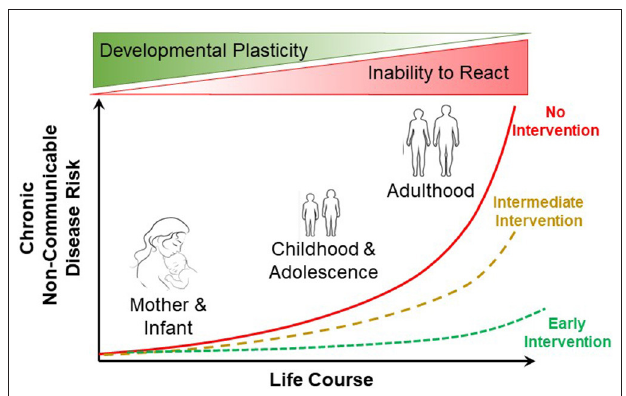
FIGURE 1 | Influence of early life course intervention on the risk of non-communicable disease in humans. Early intervention (e.g., improved maternal and neonatal nutrition) can result in greatly reduced risk of non-communicable disease in adulthood. Modified from Baird et al. (2017).